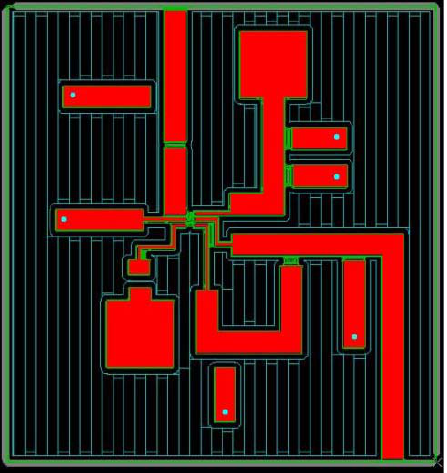
Figure 9. Layout of the microstrip board for power